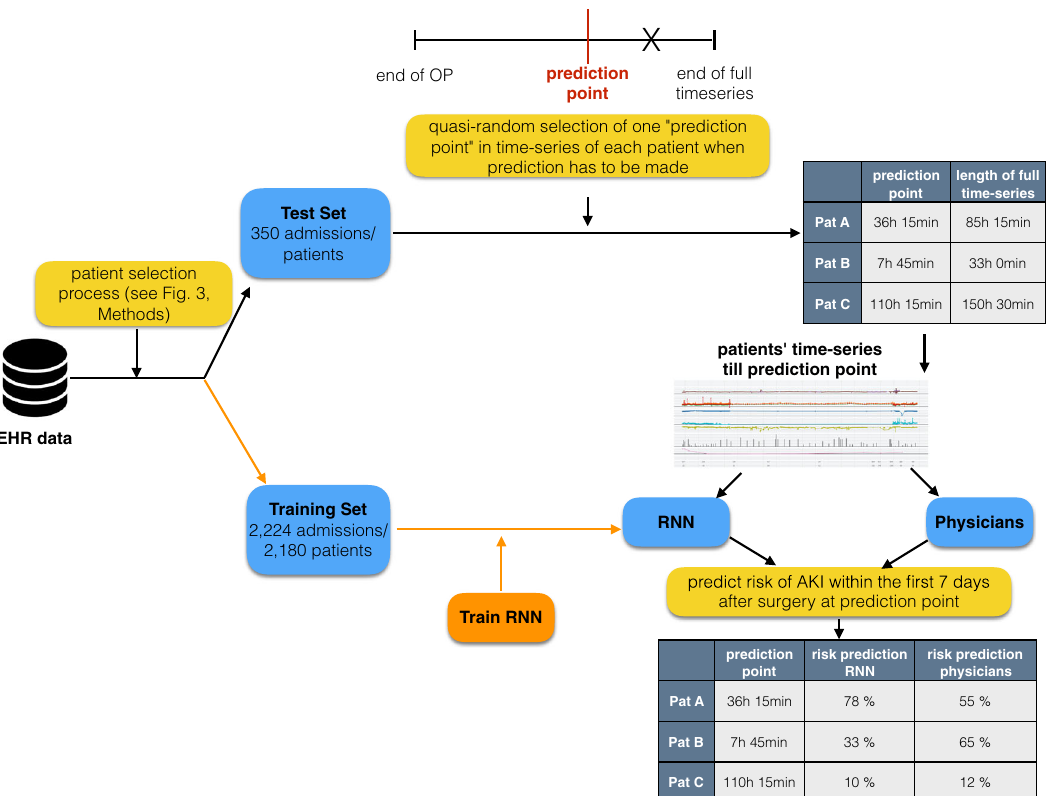
Fig. 1 Experimental design for performance comparison of recurrent neural network (RNN) against physicians. The electronic health record (EHR) data was split into a training and a test set. The training set was used for the development of the RNN (orange path). For each patient (Pat) in the test set, a quasi-random ‘ prediction point ’ in the time-series was chosen (for more information about quasi-randomness see ‘ Methods ’ ). EHR data up to this prediction point was given to physicians and RNN (the rest of the time series data, here denoted as X, was hidden). Both physicians and RNN, had to make a prediction for postoperative AKI at this prediction